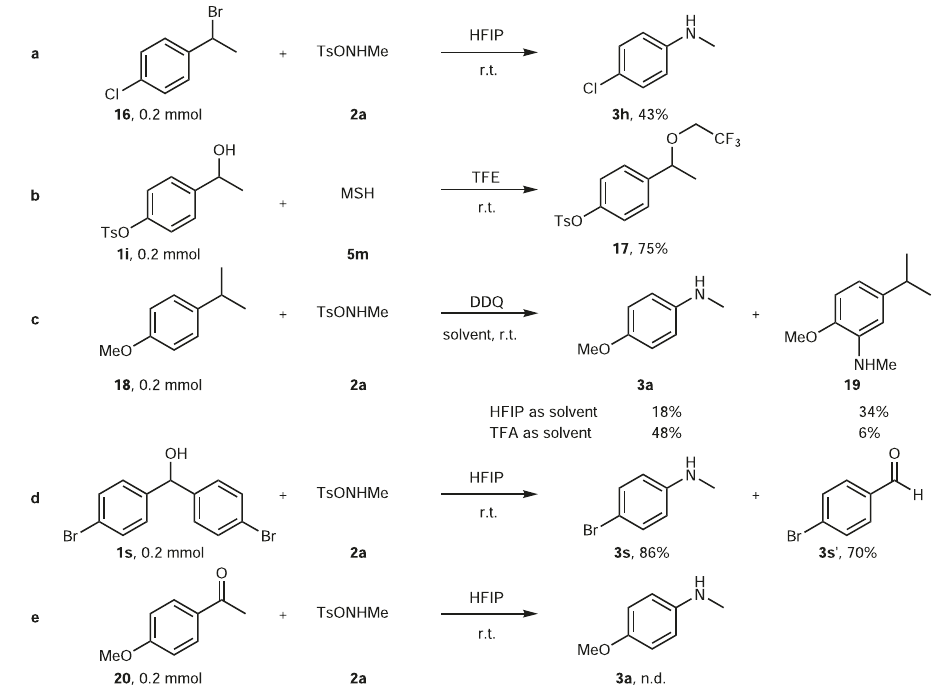
Fig. 7 Mechanistic studies. a Control experiment with benzyl halide. b Side reaction from benzyl alcohol. c Control experiment with alkylarene. d Byproduct from diphenyl methanol. e Exclusion of Beckmann rearrangement for the reaction mechanism. Ts toluenesulfonyl, HFIP hexa fl uoroisopropanol; TFE tri fl uoroethanol.